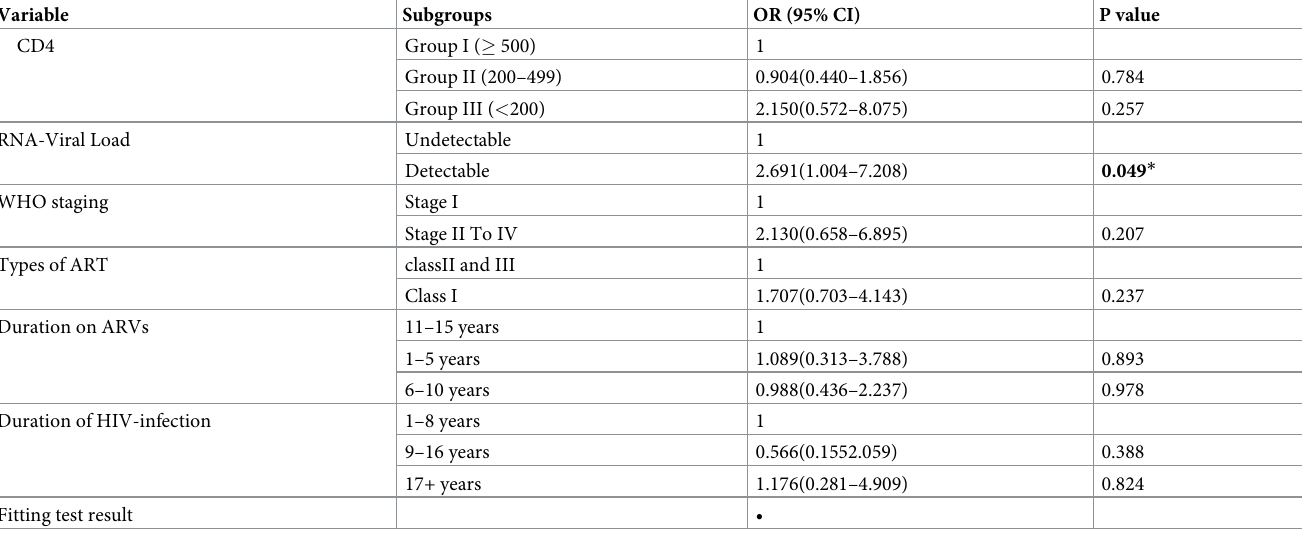
p Table 4. Logistic regression analysis of HIV related factors associated with dental caries among